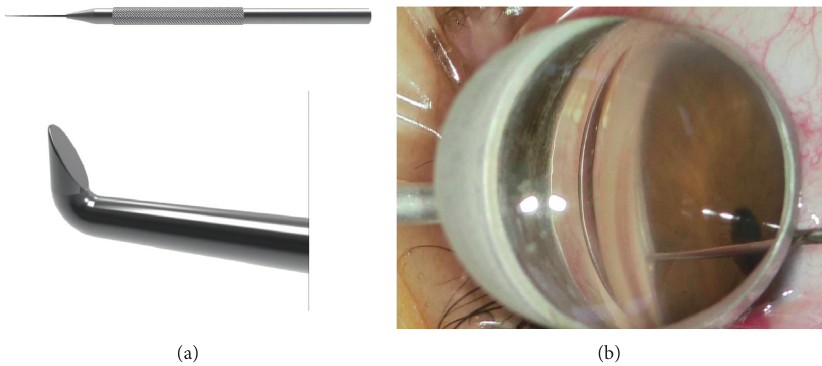
Figure 1: Microhook and intraoperative findings of microhook ab interno trabeculotomy. (a) The image shows the spatula-shaped microhook designed for use during ab interno microhook trabeculotomy (M-2215, Inami, Tokyo, Japan) and a photomacrograph of the tip of the microhook. (b) The tip of the microhook is inserted directly into Schlemm’s canal temporally and moved circumferentially to incise the inner wall of Schlemm’s canal and trabecular